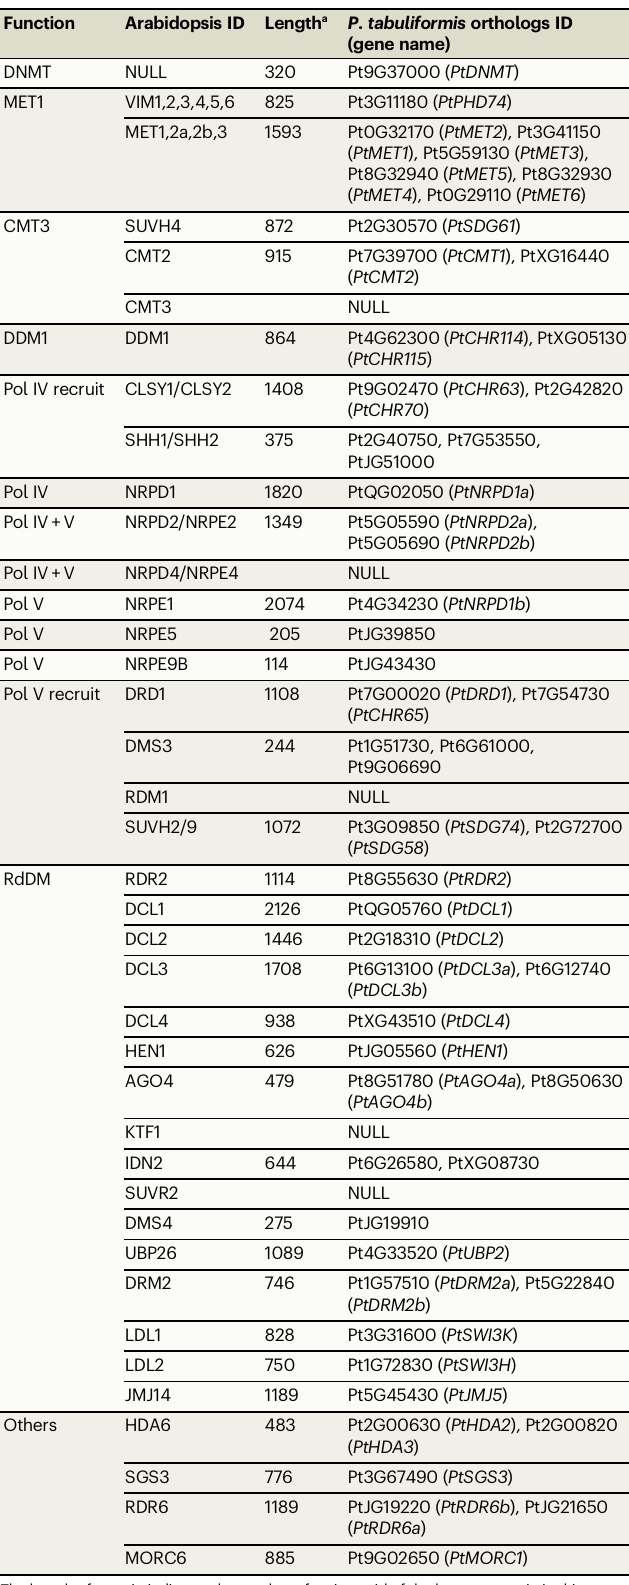
Table 1 | Putative DNA methylation pathway genes in Chinese pine Function Arabidopsis ID Length a P. tabuliformis orthologs ID